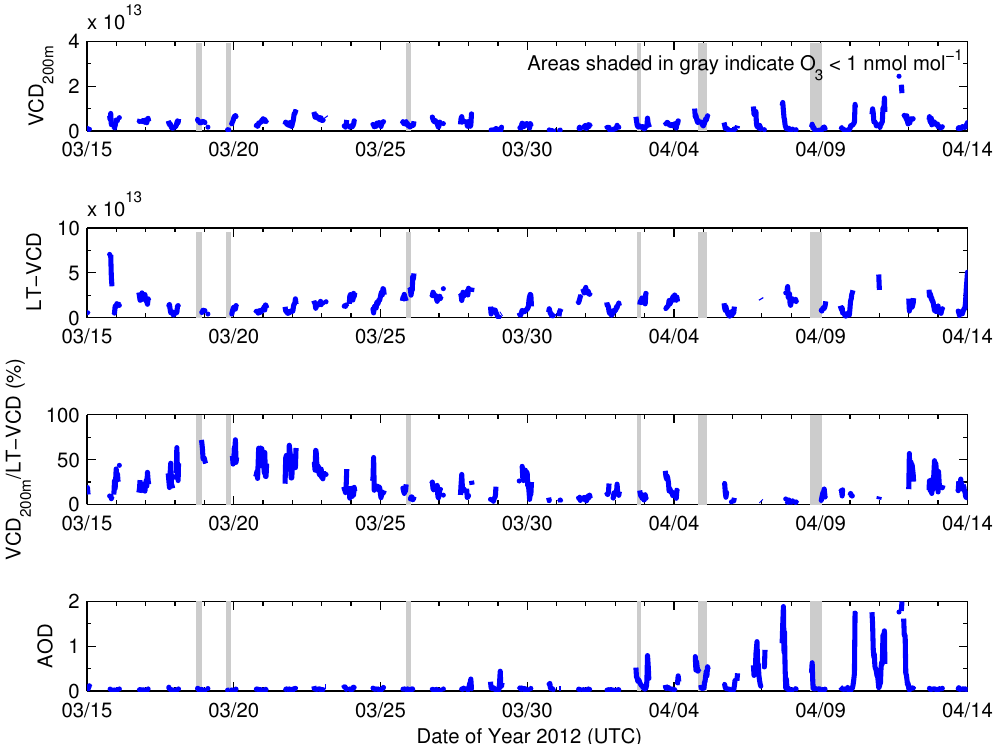
Figure 4. A portion of the time series of BrO observed during this study. The top panel represents the VCD 200m , the second panel represents the LT-VCD, both of which have units of molecules per square centimeter. The third panel shows the percentage of the LT-VCD observed in the lowest 200m, while the bottom panel shows the aerosol optical depth over the course of this study. In the third panel, ratios are not calculated for events that have a LT-VCD below 5 × 10 12 moleculescm − 2 . Shaded areas represent potentially titrated air masses near the surface (ozone < 1nmolmol − 1 ). The full time series can be found in the